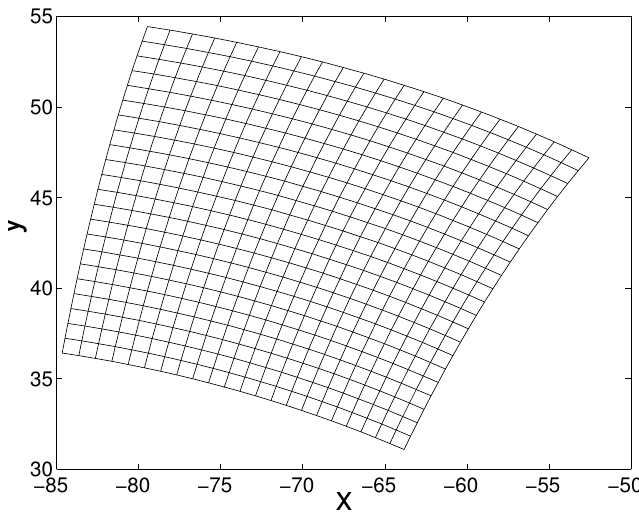
Figure 1. Computation domain and discretization mesh.